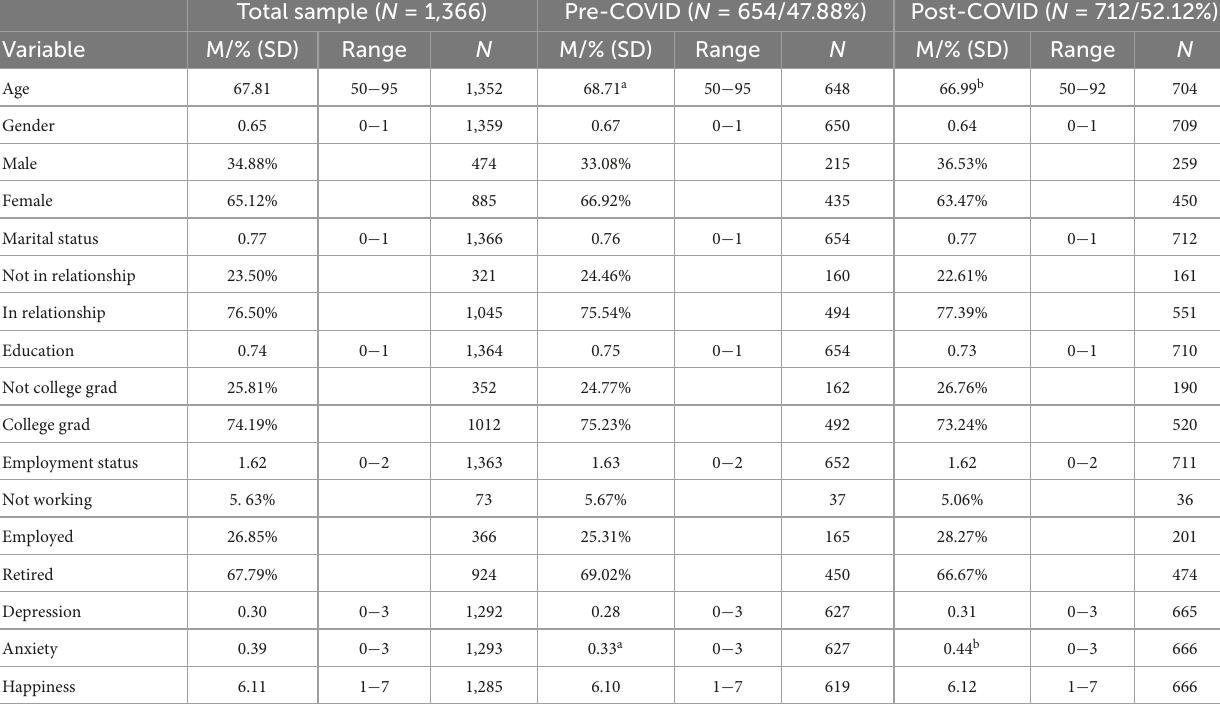
TABLE 1 Descriptive statistics for study 1 with the total sample ( N = 1,366).